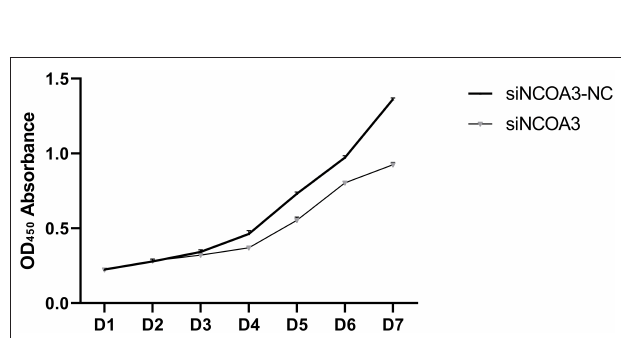
FIGURE 5 | The effect of interfering expression of NCOA3 on cell viability of PSCs. The assay lasts for seven days.